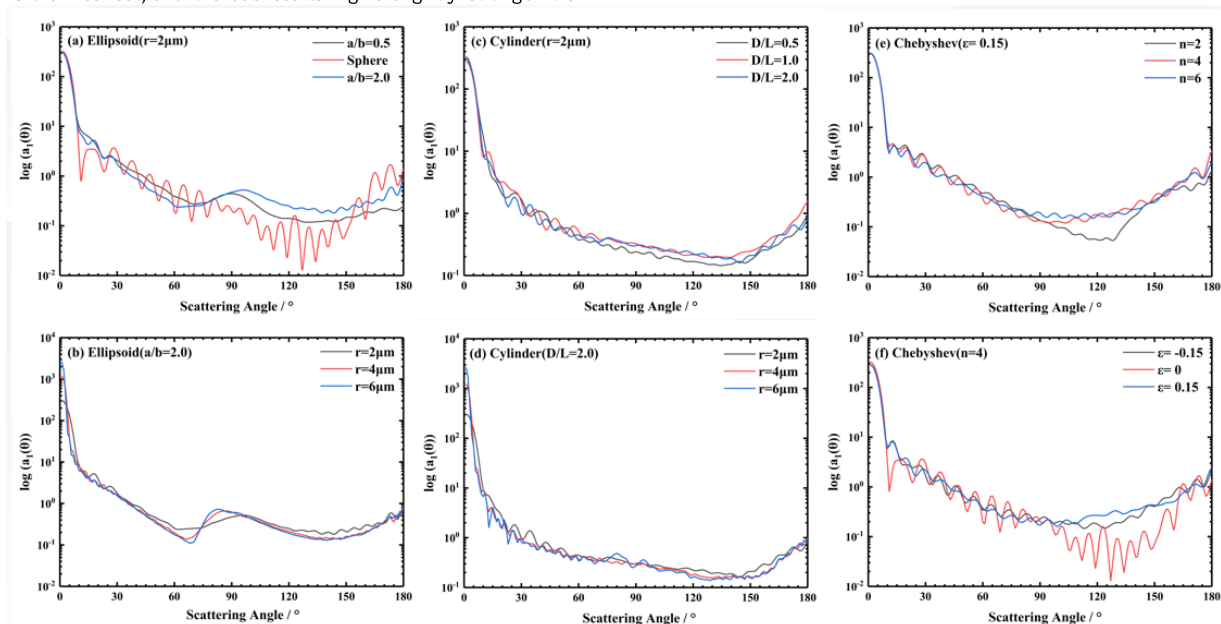
Figure 2. The distributions of scattering phase function with regard to scattering angle for six different shapes. It is noted that logarithmic transformation is used for scattering energy. (a) Phase function of ellipsoidal particles with different aspect ratio(r=2μm). (b)Phase function of ellipsoidal particles with different equivalent radius(a/b=2). (c) Phase function of cylindrical particles with different aspect ratio(r=2μm). (d)Phase function of cylindrical particles with different equivalent radius(D/L=2). (e) Phase function of different polynomials of Chebyshev particles (r=2μm, ε=0.15). (f) Phase function of different deformation parameters of Chebyshev particles (r=2μm,